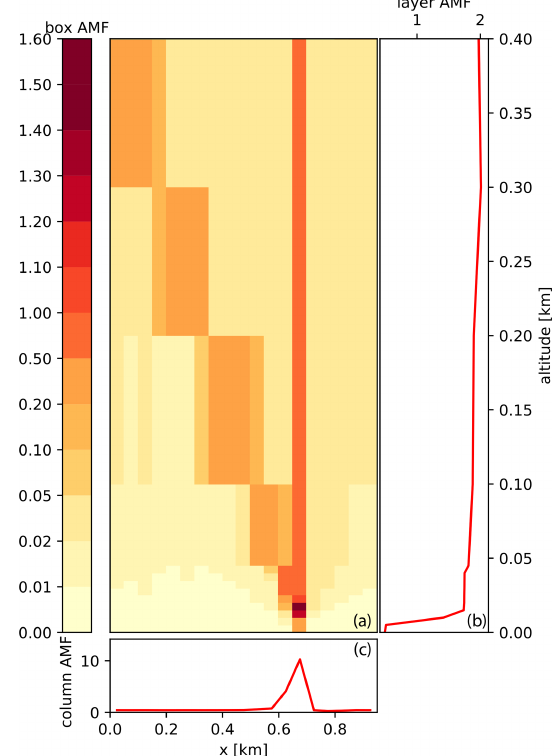
Figure 4. (a) Integrated 3D-box AMFs in y direction for a ground pixel at x = 650 and y = 50m (lower left corner) for an instrument placed at x = 600, y = 75 and z = 6000m. The sun is at SAA = 90 ◦ (west) with a SZA of 60 ◦ . (b) Vertical profile of horizontally inte- grated AMFs (1D-layer AMFs) and (c) horizontal profile of verti- cally integrated AMFs (column